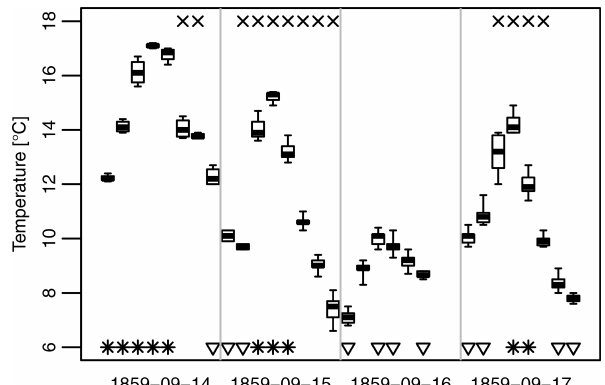
Figure 6. Results of the comparison described in Wild (1860). The boxes give the temperature range measured by up to seven ther- mometers in different positions every 2h between 08:00 and 22:00. The symbols indicate weather conditions observed by Wild (aster- isk: sunshine, triangle: rain, cross: